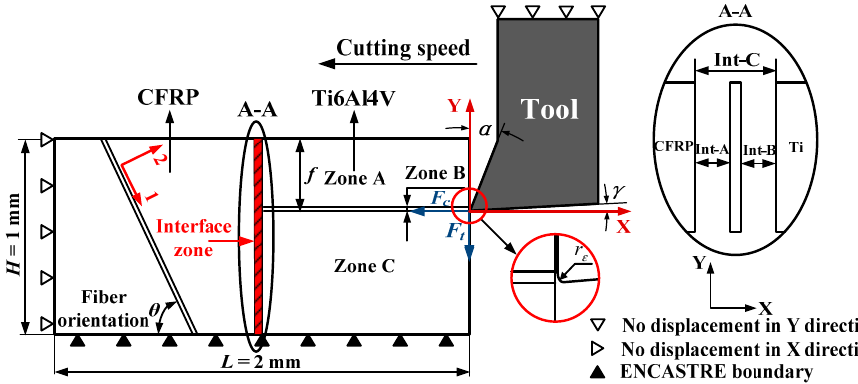
Figure 1. Scheme of the established orthogonal cutting (OC) model for hybrid CFRP/Ti machining ( α = 12 ˝ and γ = 7 ˝ ): (1,2) represents the material coordinate system where 1 Ñ fiber direction, 2 Ñ transverse direction, F c indicates the cutting force and F t signifies the thrust force (ENCASTRE boundary indicates the fully fixed end). (see Abbreviations